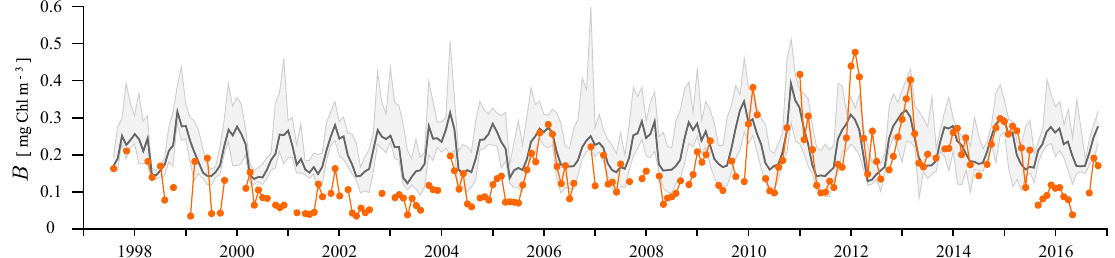
Figure 6. Time-series of measured (orange) and remotely-sensed chlorophyll (grey). Measured chlorophyll corresponds to the vertically-averaged chlorophyll concentration for each profile. The grey curve is the mean remotely-sensed chlorophyll concentration, and the shaded area corresponds to the min-max range. Data are from September 1997–December